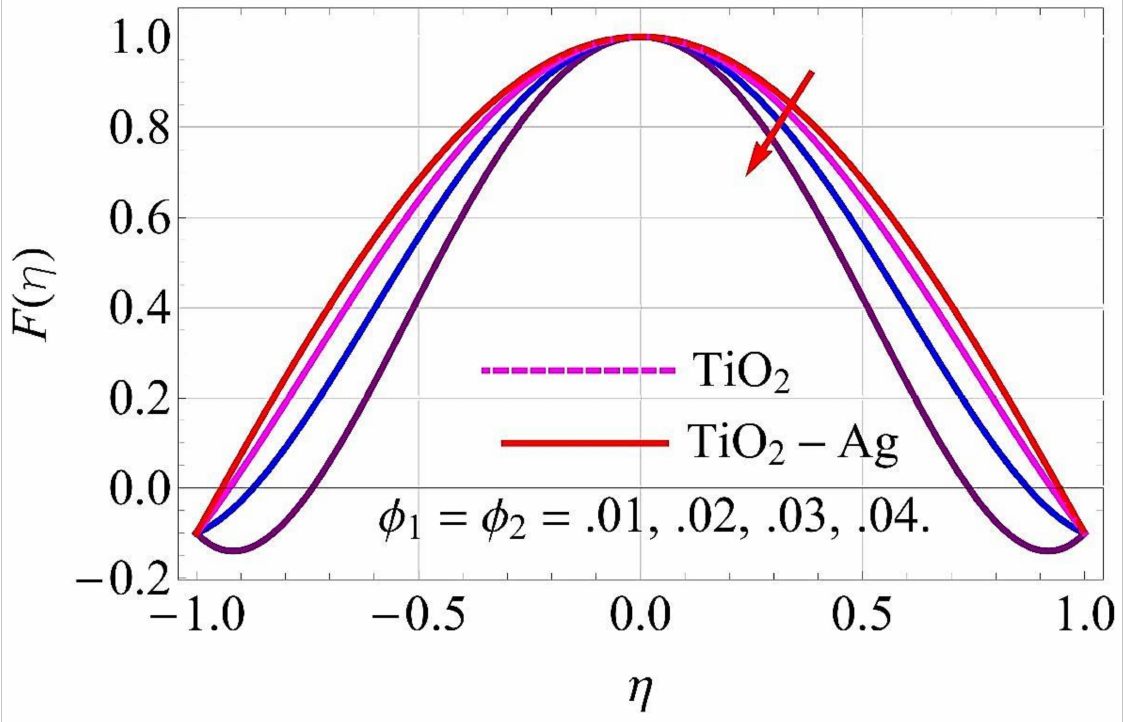
Figure 4. Velocity versus φ 1 , φ 2 with α = 5 ◦ for diverging/shrinking circumstances. When Re = 25, Rd = 0.4, Ec = Ha = Q = Fr = k ∗ = K 1 =